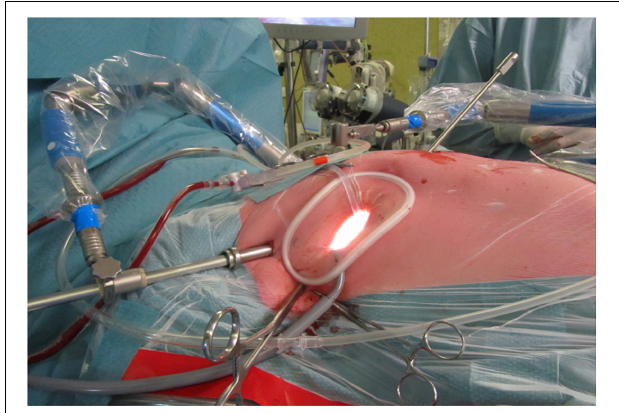
FIGURE 1 | The set-up for a minimally invasive port-access approach through a right anterolateral thoracotomy, as performed in the Sint Antonius Hospital Nieuwegein. The patient is positioned in a 30* left lateral position with the right arm placed posteriorly, with a sand bag under de right scapula. A soft tissue retractor is used without additional rib spreading. Depicted are the atrial roof retractor, camera port and aortic cross-clamp (from medial to right